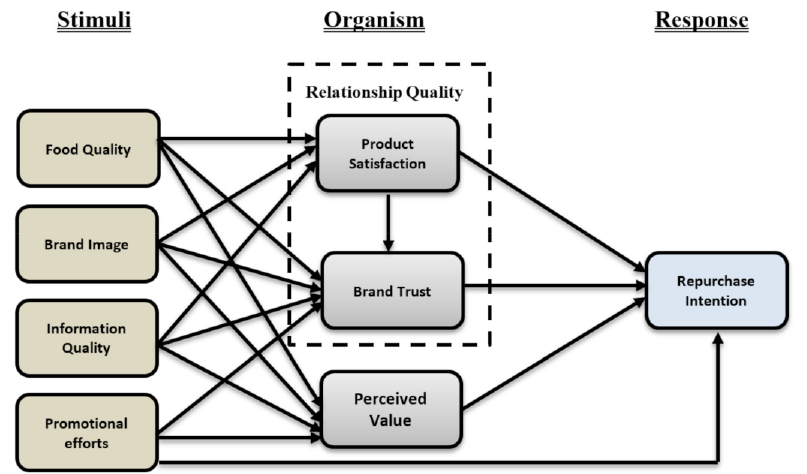
Figure 1. Conceptual